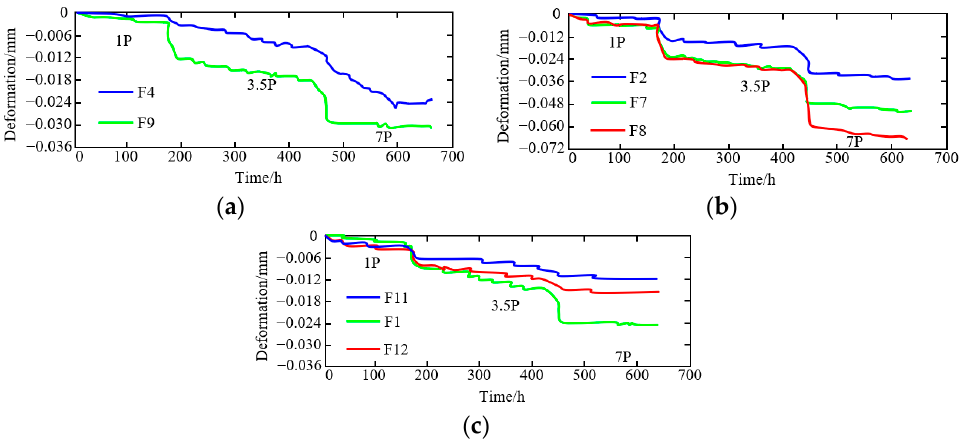
Figure 14. Deformation–time curve of dislocation gauge: ( a ) back anchor surface; ( b ) middle anchor; ( c ) front anchor. Table 2. Flow deformation of dislocation meter.